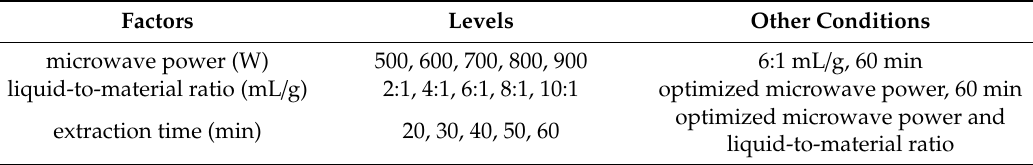
Table 3. The single factor test design.